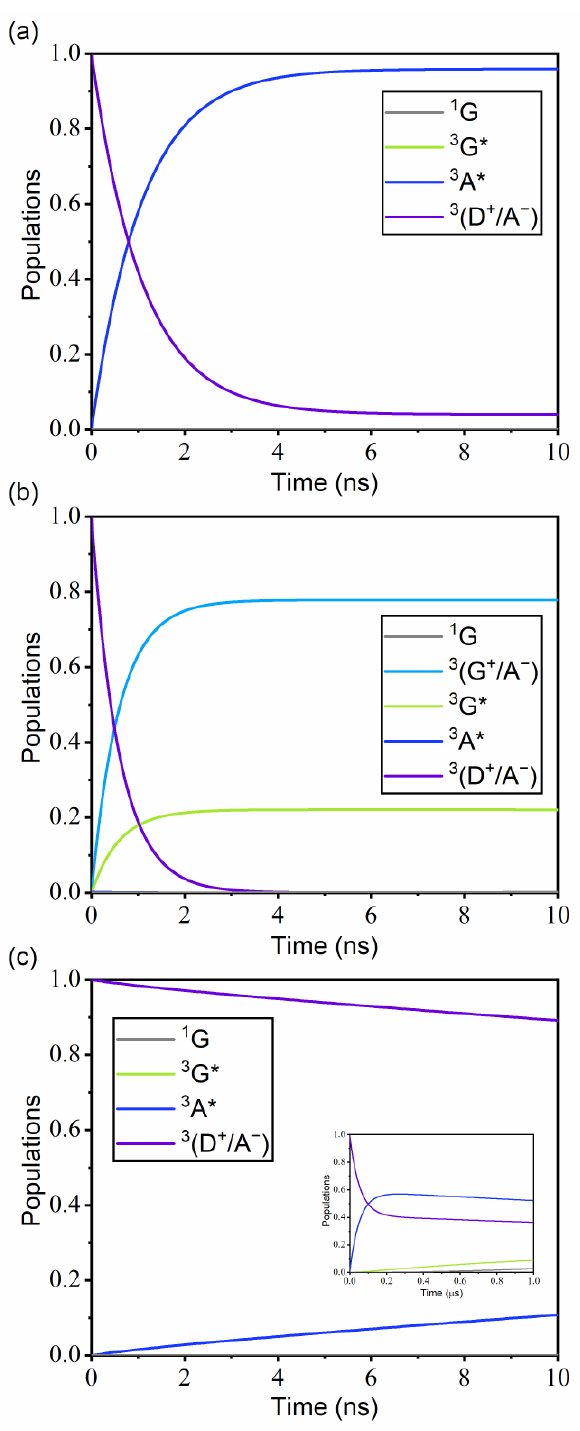
Figure 9. Population changes of the considered electronic states for ( a ) 3 (Ir(ppy) 3 /TCTA/TPBI), ( b ) 3 (TCTA/TPBI/Ir(ppy) 3 ), and ( c ) 3 (TCTA/Ir(ppy) 3 /TPBI) with the assumption that the initiating state is the lowest 3 (D + /A − ) state. Inset in ( c ) shows the data in the long-time limit. Each excited population is a sum of sub-populations as described in Figure 8. The considered electronic states are listed in Table S2. Rate constants were calculated with the Förster theory at 300 K, using the reorganization energy of 2000 cm − 1 .